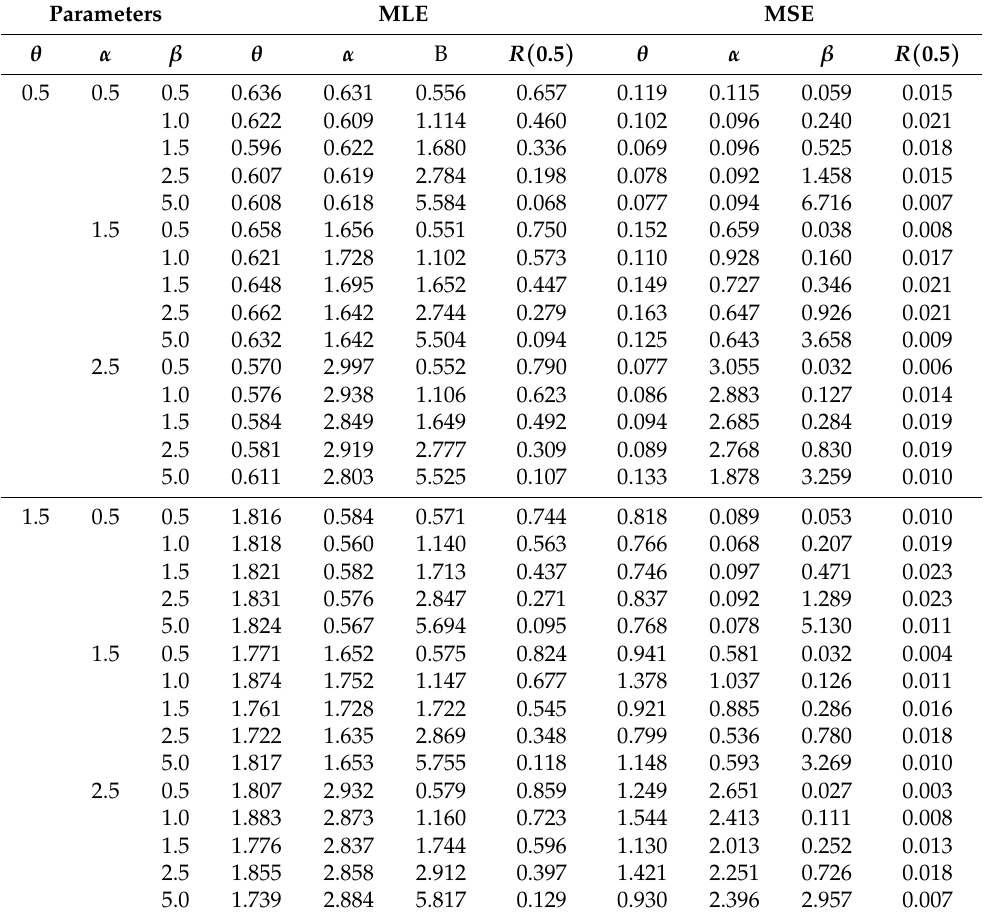
Table 2. The AVs of estimates and the corresponding MSEs for n =